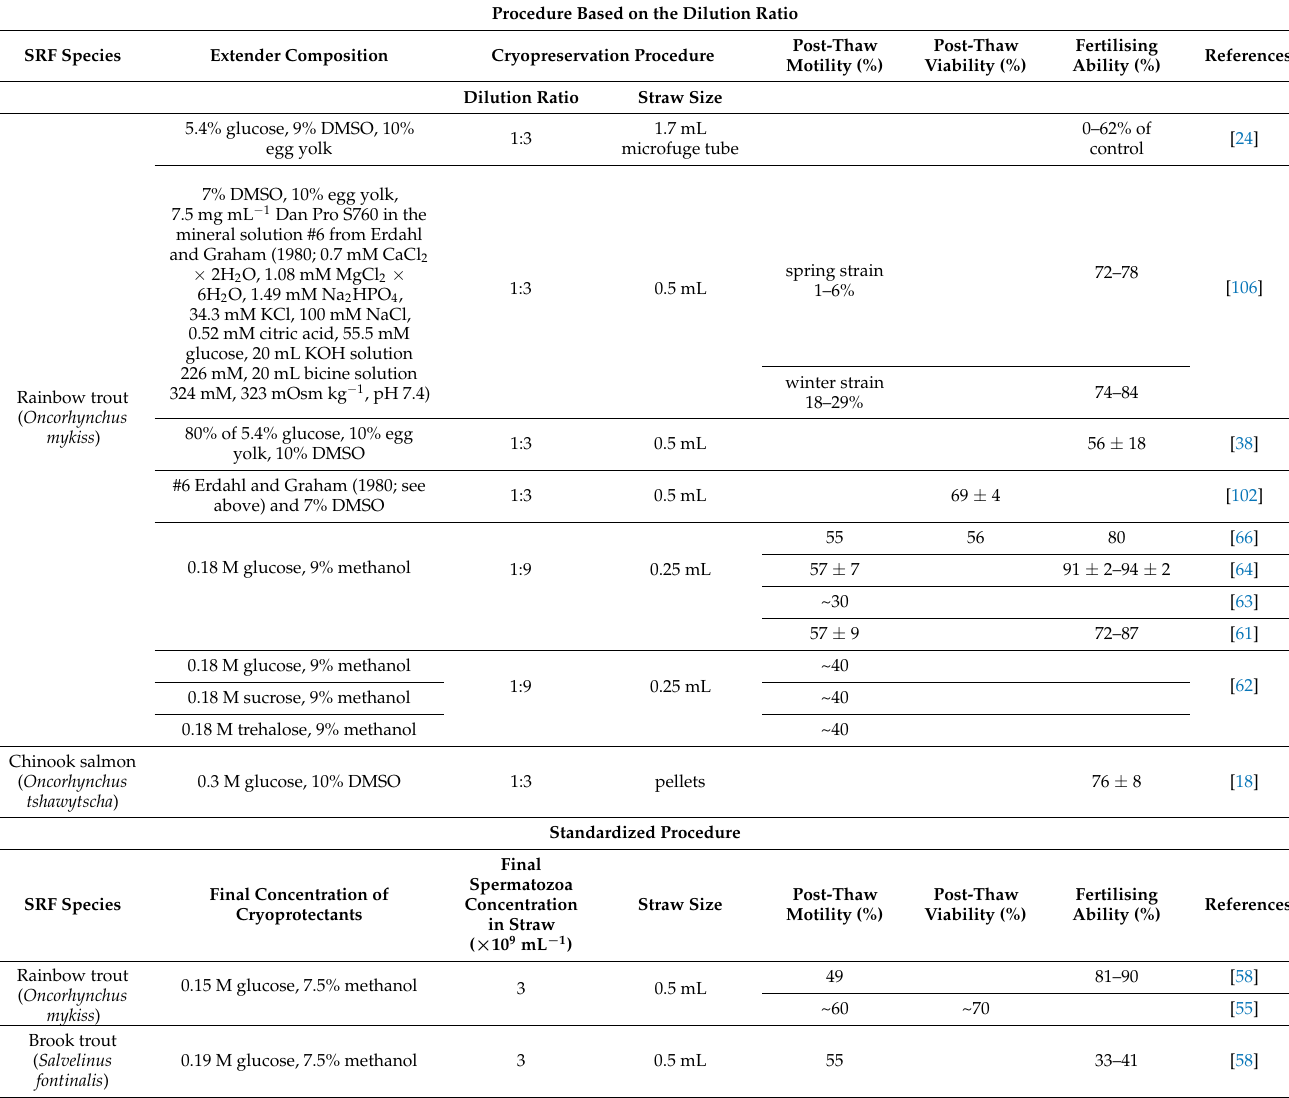
Table 5. Cryopreservation protocols for SRF